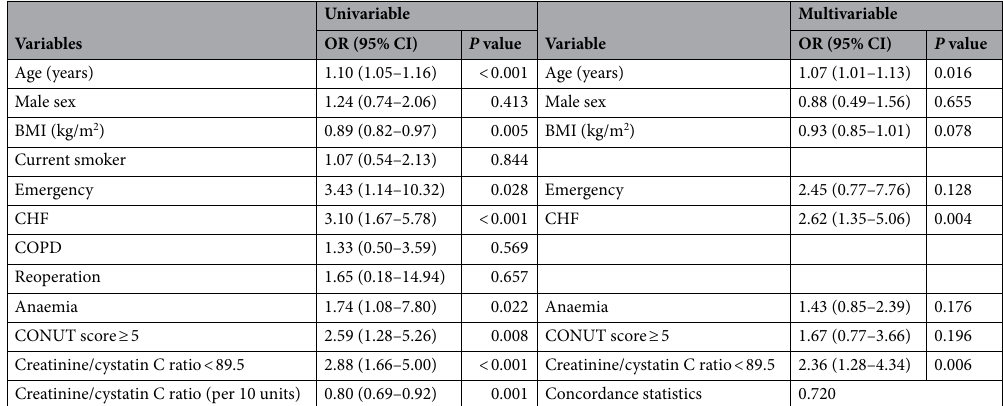
Table 4. Univariable and multivariable analysis for postoperative pulmonary complications. OR, odds ratio; CI, confidence interval; BMI, body mass index; CONUT, CONtrolling NUTritional status; CHF, congestive heart failure; COPD, chronic obstructive pulmonary